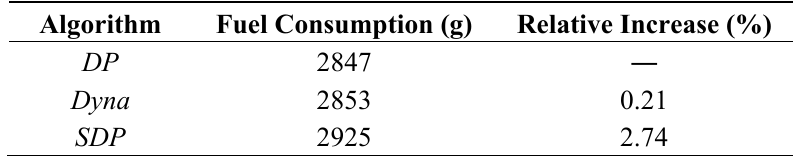
Figure 13. SOC trajectories and engine operation area in the Dyna algorithm, SDP, and DP. Table 4. Fuel consumption in the Dyna algorithm, SDP, and DP.